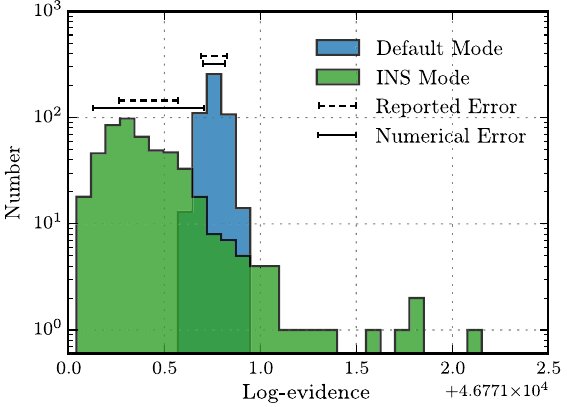
FIG. 19. Histograms of MultiNest log-evidence (for the TVS model; see Sec. IV) obtained by evaluating a single simulated data set 500 times in both the default and INS modes. To generate the simulated data, we assume a 1-year observation of a tensor background ( Ω T 0 ¼ 2 × 10 − 8 and α T ¼ 2 = 3 ) with design-sensitivity Advanced LIGO. The dashed error bars show the mean 68% confidence interval reported by each method, while the solid error bars show the true 68% confidence interval computed from the log-evidence